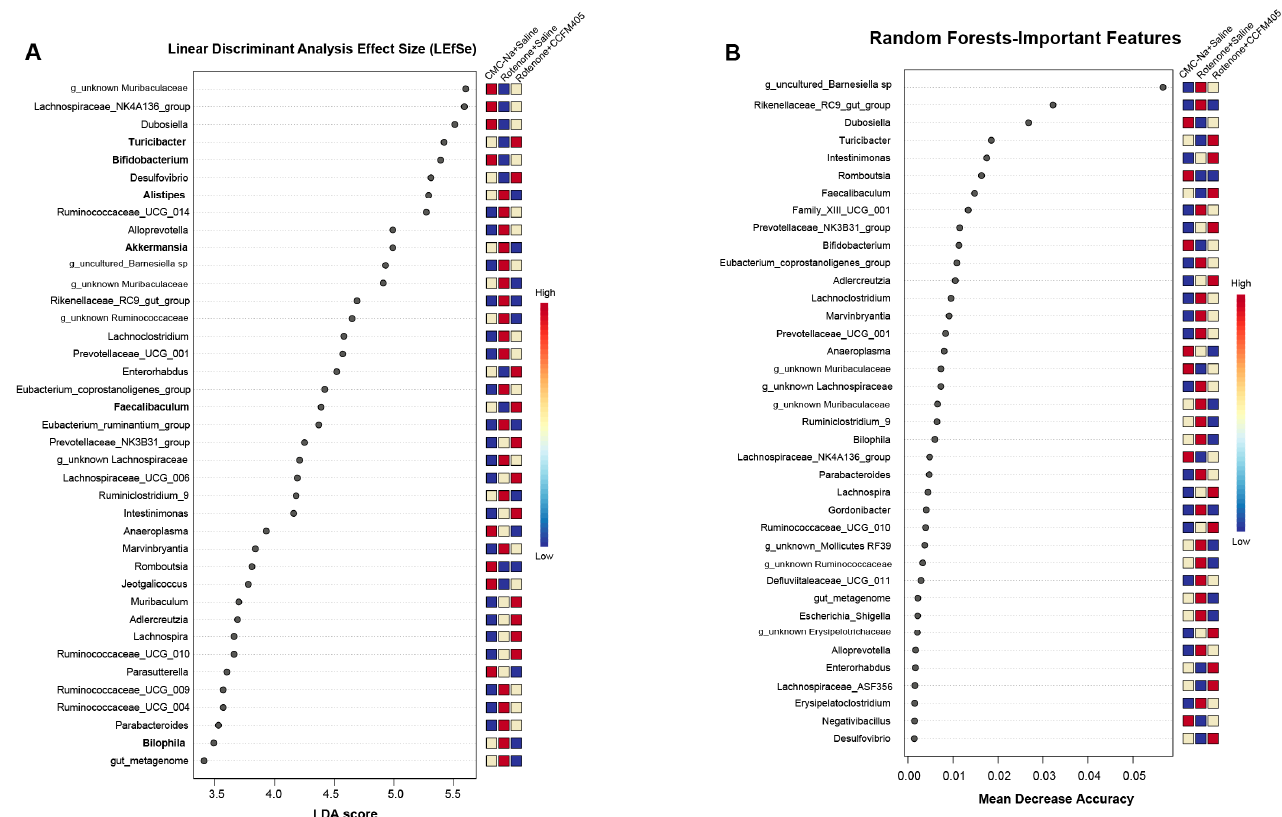
Figure 7. The general difference and determination of specific bacteria for discrimination among the three groups. ( A ) The linear discriminant analysis effect size (LEfSe) for three groups, with marked genera ranked in descending order by LDA value and a heatmap displaying matching genera that are either higher (red) or lower (blue); ( B ) the thirty-five most predictive genera were filtered by random forest classifier with feature importance scores. Feature importance was determined by cal- culating the mean decrease in model accuracy that resulted from randomly shuffling its values, n = 10/group.